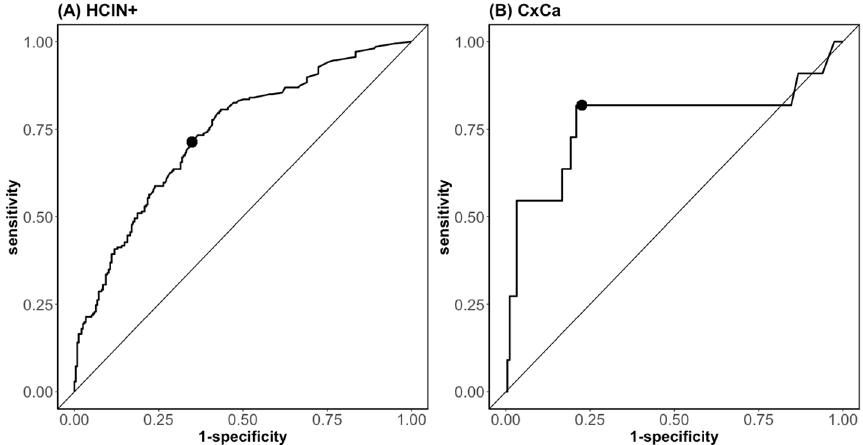
Figure 4. Accuracy of dysplasia detection by QG-POC assay. Shown are the ROC curves for the multivariate logistic regression models of the clinical borders ( A ) HCIN+ and ( B ) CxCa combining the expression strength of the biomarkers, leading HPV-E7 and p16 INK4a . The points represent the best cut-off balance between sensitivity and specificity, i.e., accuracy. The diagonal represents the ROC of an uninformative marker or test.